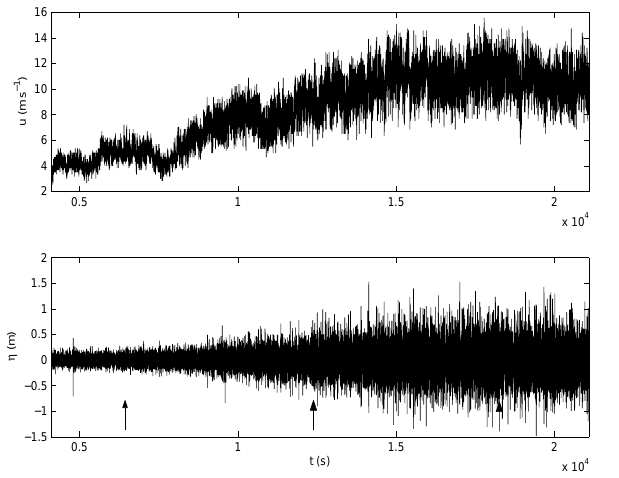
Fig. 2. Fourier wave spectra in three episodes (starting at t =5859s, 11719s, and 17578s, respectively) of wave development; the du- ration of each episode was approximately 20min.